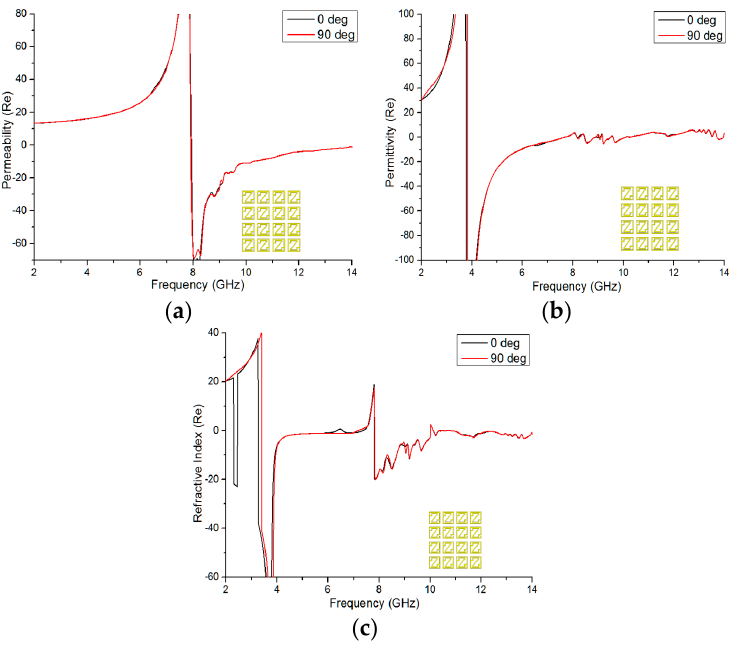
Figure 9. Real magnitude of ( a ) the effective permeability; ( b ) the effective permittivity; and ( c ) the refractive index of the 90-degree rotated 4 × 4 array configuration.